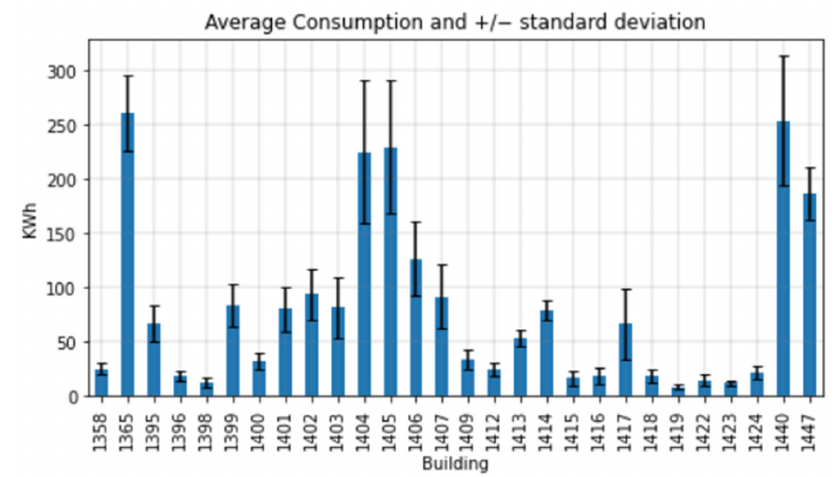
Figure 2. Hourly electricity consumption for the 28 considered